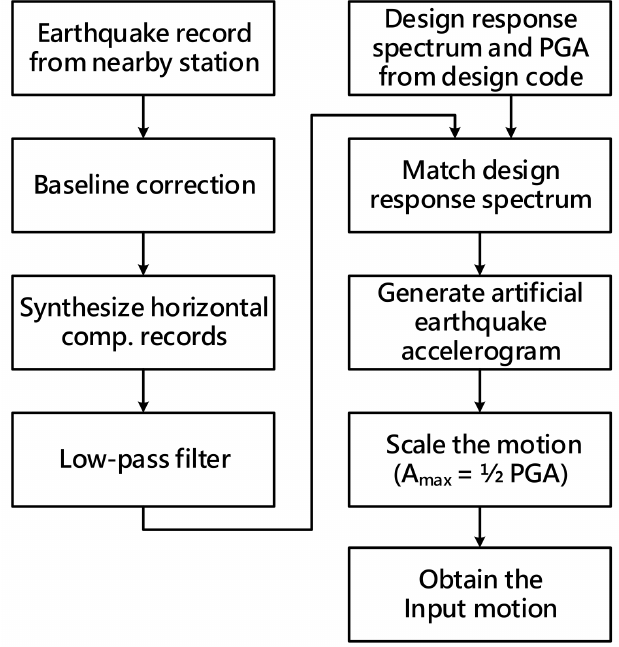
Figure 10. The procedure to determine the input